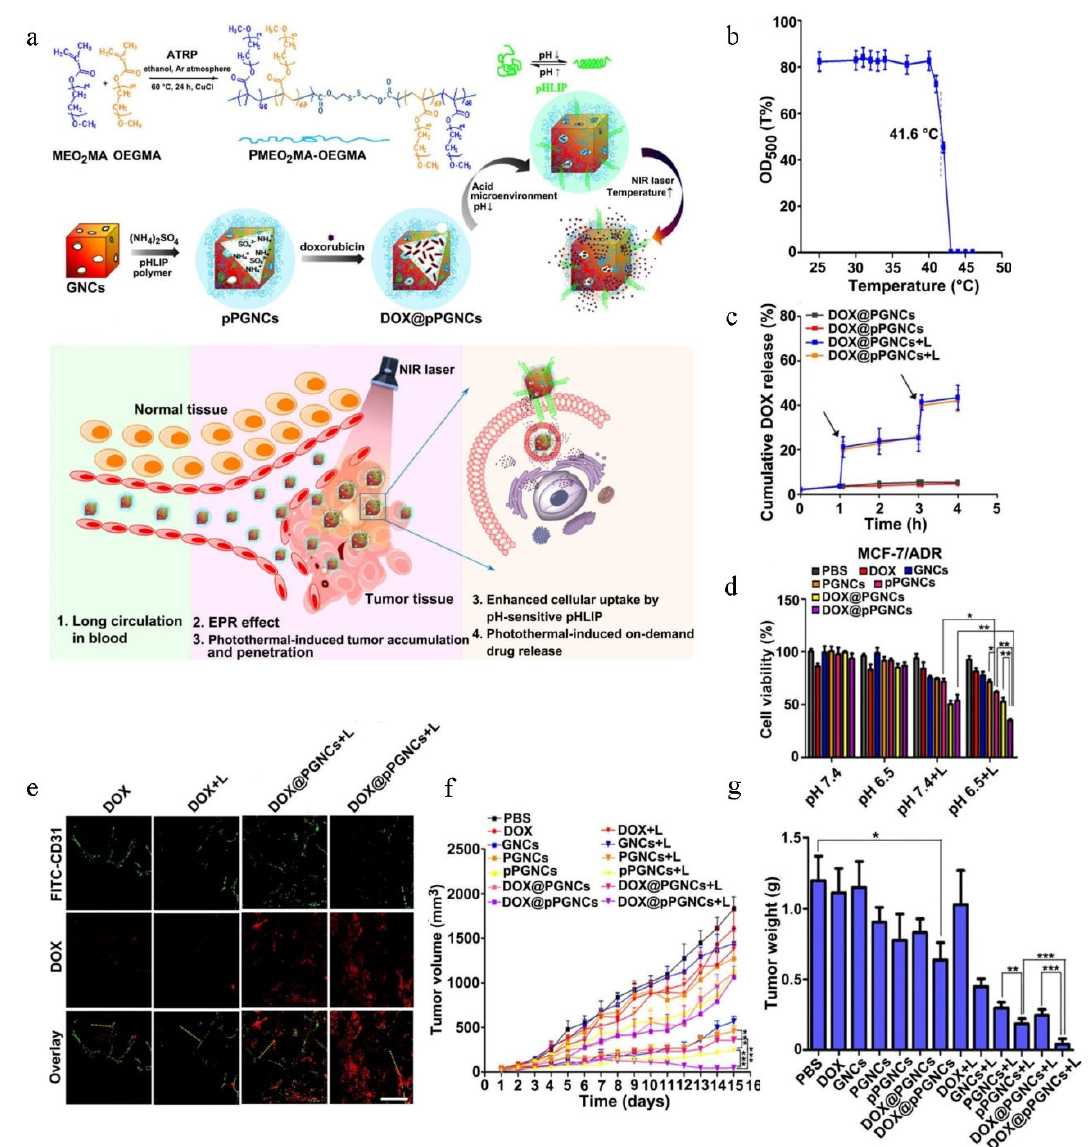
Figure 3. DOX@pPGNCs for chemo ‐ photodynamic combination therapy of drug ‐ resistant cancer. Reprinted with permission from Ref. [99]. 2019, NIH. ( a ) Schematic diagram of the mechanism of DOX@pPGNCs surmounting cancer drug resistance. ( b ) Transmittance of POEG in PBS. ( c ) In vitro